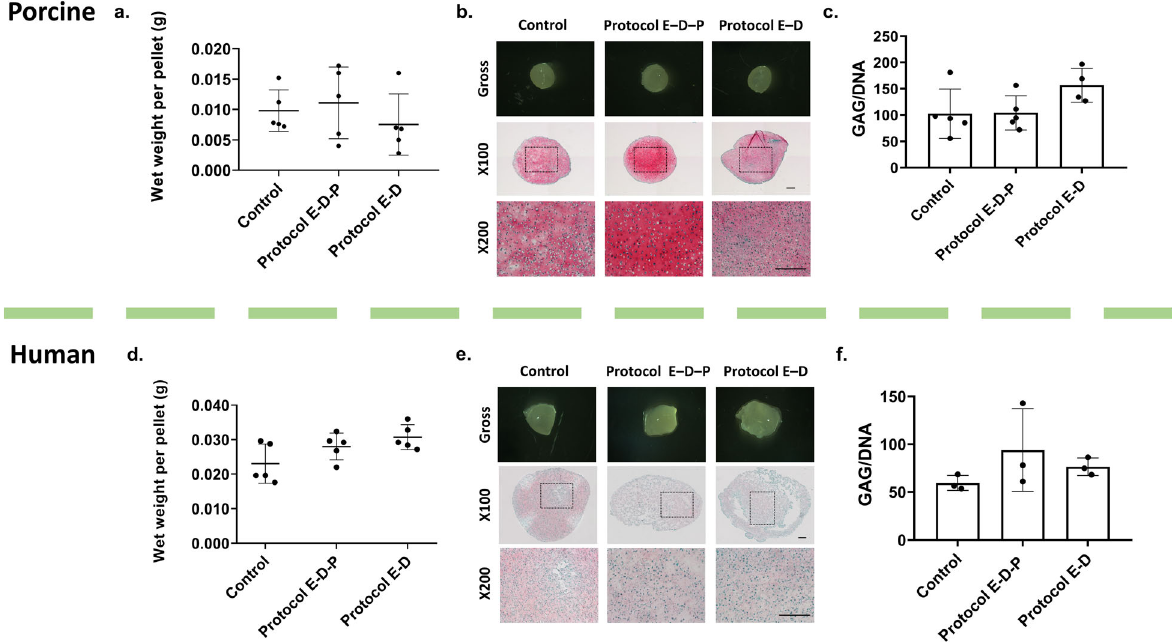
Fig. 5 Assessment of matrix productivity of chondrocytes isolated from articular cartilage after vitri fi cation and subsequent rewarming. a Porcine pellets after a 21-day culture show a similar wet weight among the fresh control, Protocol E – D – P, and Protocol E – D groups ( n = 5 replicates per group, p = 0.074, one-way ANOVA). b Representative histological images showing the gross appearance of porcine pellets after a 21-day culture with chondrogenic media under hypoxic conditions (3% O 2 , 5% CO 2 at 37 °C). Safranin O stain showing GAG content synthesized by viable and active chondrocytes for the fresh control, Protocol E – D – P, and Protocol E – D groups. c GAG/DNA quanti fi cation of porcine pellets show similar matrix productivity among the fresh control, Protocol E – D – P, and Protocol E – D groups ( n = 4 – 5 replicates per group, p = 0.106, one-way ANOVA). d Human pellets after a 21-day culture show similar wet weights among the fresh control, Protocol E – D – P, and Protocol E – D groups ( n = 5 replicates per group, p = 0.054, one-way ANOVA). e Representative histological images showing the gross appearance of human pellets after a 21-day culture with chondrogenic media under hypoxic conditions (3% O 2 , 5% CO 2 at 37 °C). Safranin O stain showing GAG content synthesized by viable and active chondrocytes for the fresh control, Protocol E – D – P, and Protocol E – D groups.